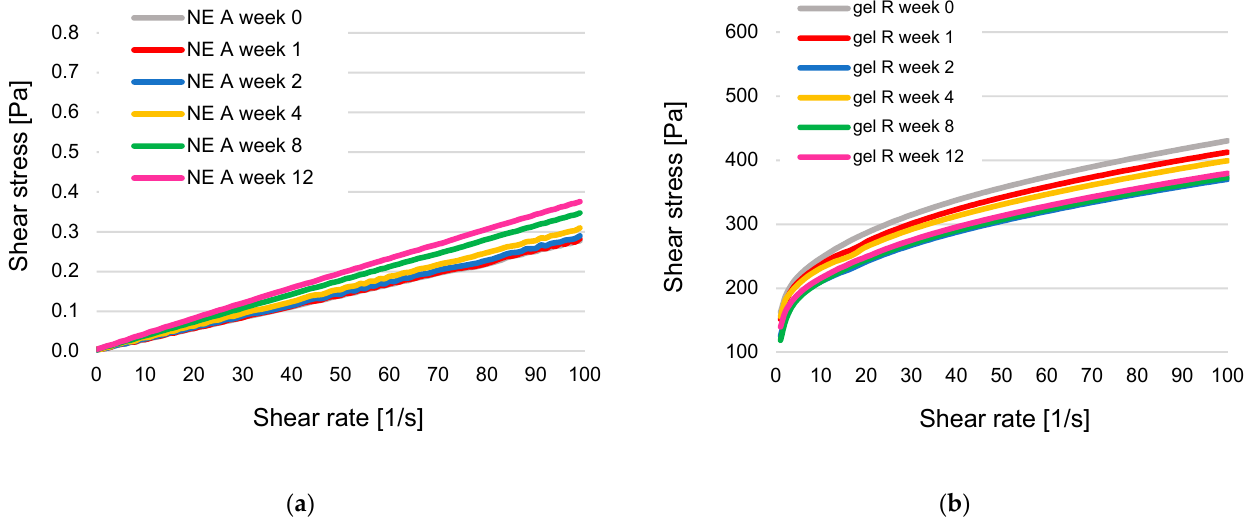
Figure 6. Flow curves of ( a ) oil-in-water NEs (exemplary: NE A) and ( b ) hydrogels (exemplary: gel H) as monitored over twelve weeks. The coloured curves are means of n = 3 formulations analysed at room temperature (23 °C) at a shear rate of 1–100 s − 1 . For better visualisation, SDs are omitted.